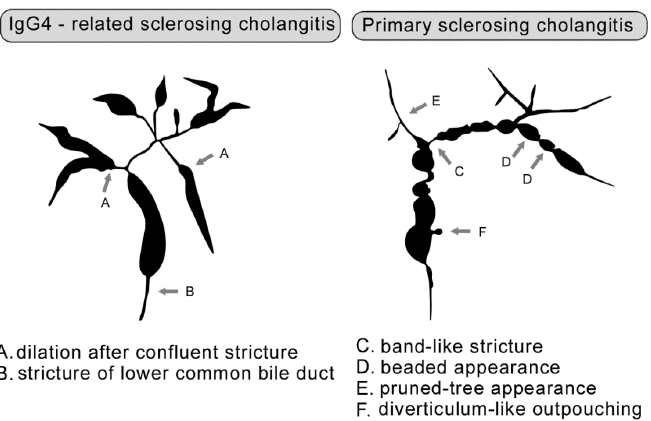
Figure 2. Comparison of cholangiographic findings of IgG4-related sclerosing cholangitis and PSC (prepared in accordance with Ohara et al. [67] and created in collaboration with the Service Center for E-Learning at Masaryk University, Faculty of Informatics).